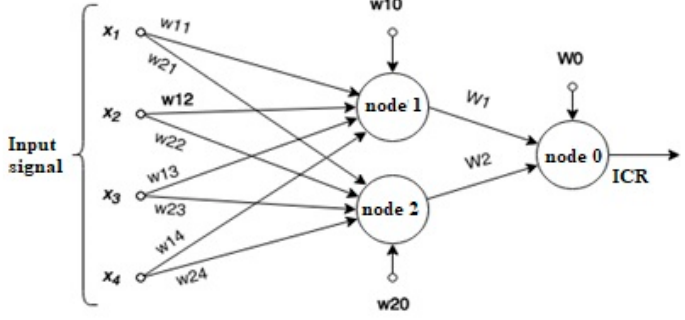
Figure 3. ANN representation (Nara et al.